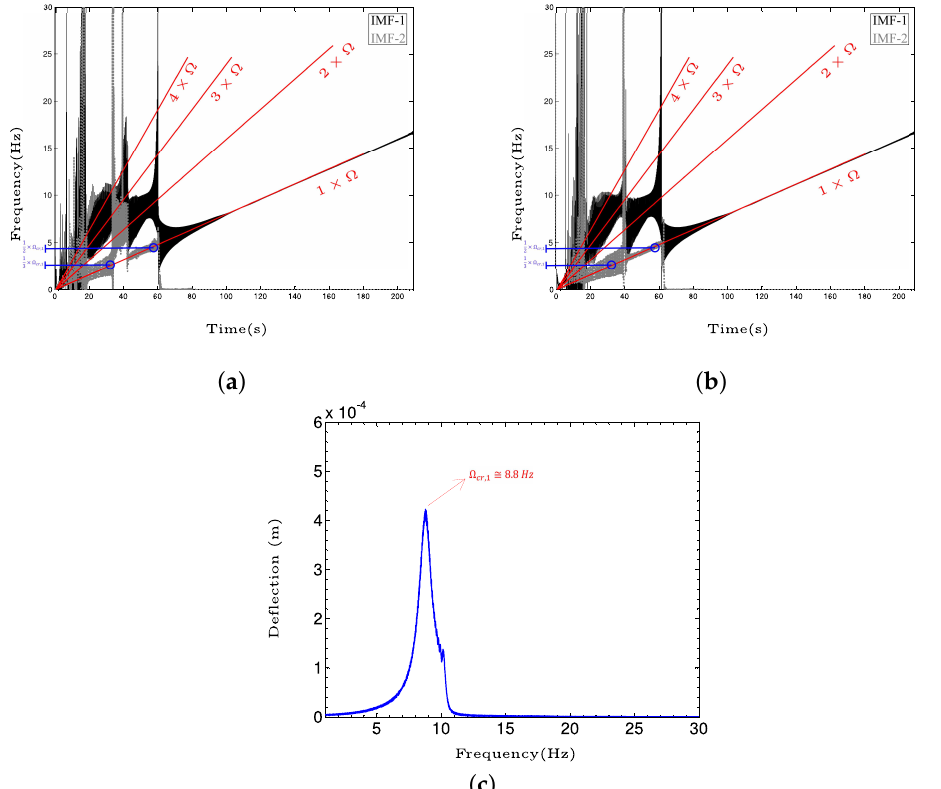
Figure 12. Time–frequency representations of the vertical transient response of the system with a deep crack, ( µ = 1 ) , using HHT based on ( a ) improved EMD, ( b ) EMD algorithms (solid line represents the instantaneous frequency of the first IMF and dotted line represents the instantaneous frequency of the second IMF), and ( c ) Fourier spectrum.